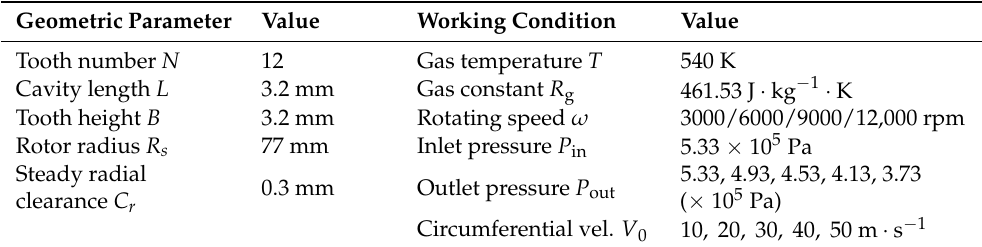
Table 1. Geometry parameters and operating conditions of the ILS-rotor system.